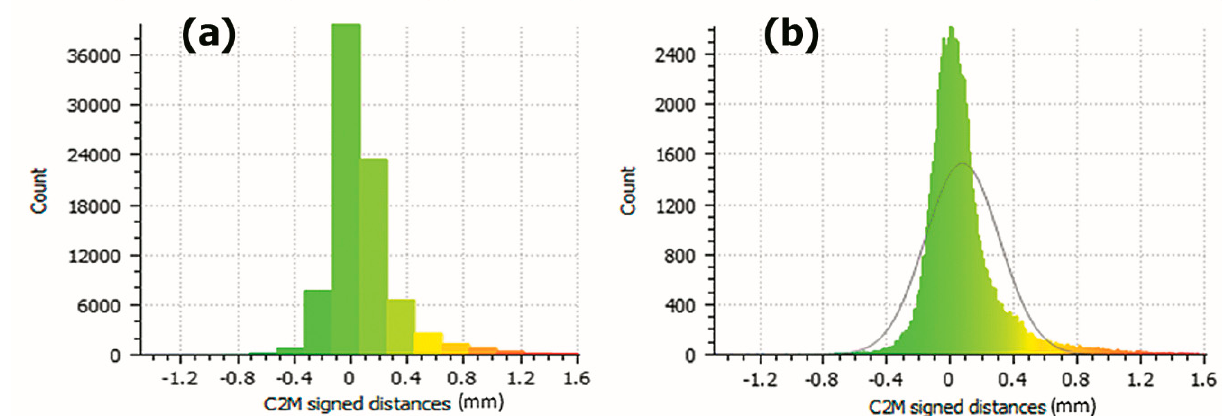
Figure 15. Charts for the Histogram and distribution generated by the Software Cloud Compare. (Source: self-made). If a limit of ± 0.2 mm is set in the error value, it is obtained that 18.828% of the points have a difference with each other larger than 0.2 mm (Figure 16a) and 4.735% of them have a difference under − 0.2mm (Figure 16b). In the central part of the graphic, the 76.437% of 83,593 points are included in a smaller difference than ± 0.2 mm.